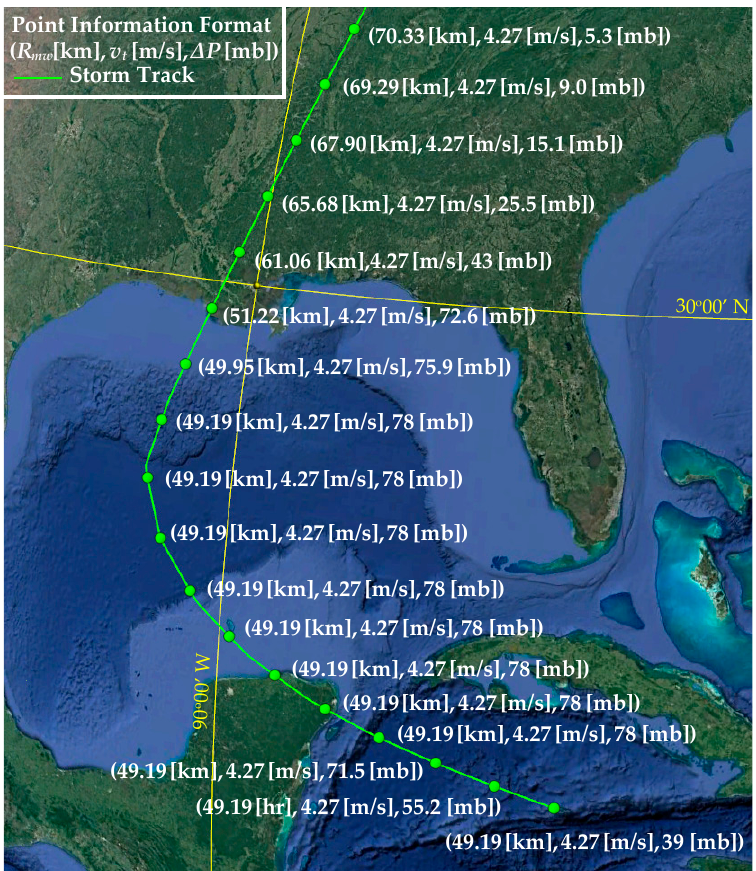
Figure 3. The variation of the storm—size, translational speed, and strength—parameters along the track for a specific storm within the database.